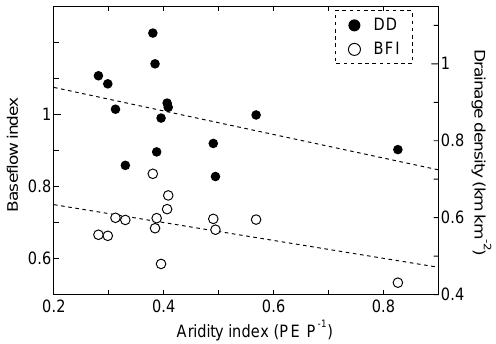
Figure 8. Climate controls on baseflow index and drainage den- sity. The relationships with aridity index were not significant for both drainage density ( R = − 0 . 451, p = 0 . 105) and baseflow in- dex ( R = − 0 . 372, p = 0 . 190).